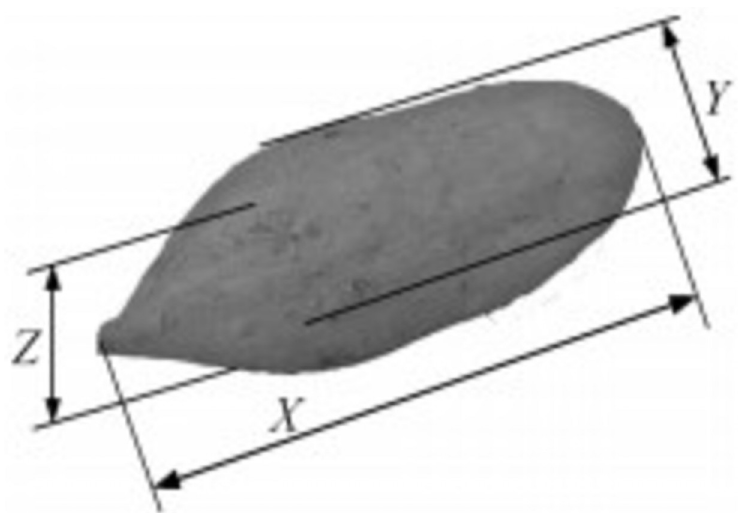
Fig 3. Characteristic dimensions of sweet potato. Calibrate the size characteristics of sweet